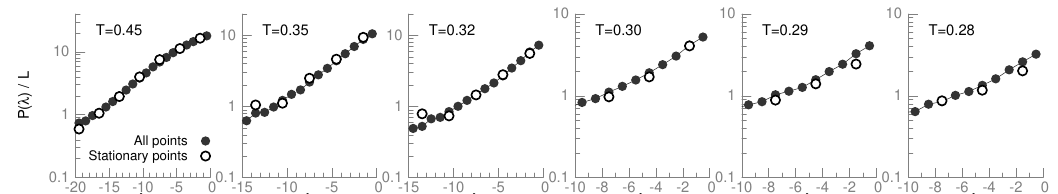
Figure 10: Scaled participation ratio P ( λ ) / L as a function of λ for the ternary mixture for all points obtained from W -minimizations (filled circles) and for stationary points only (empty circles). The number of particles is N = 500.